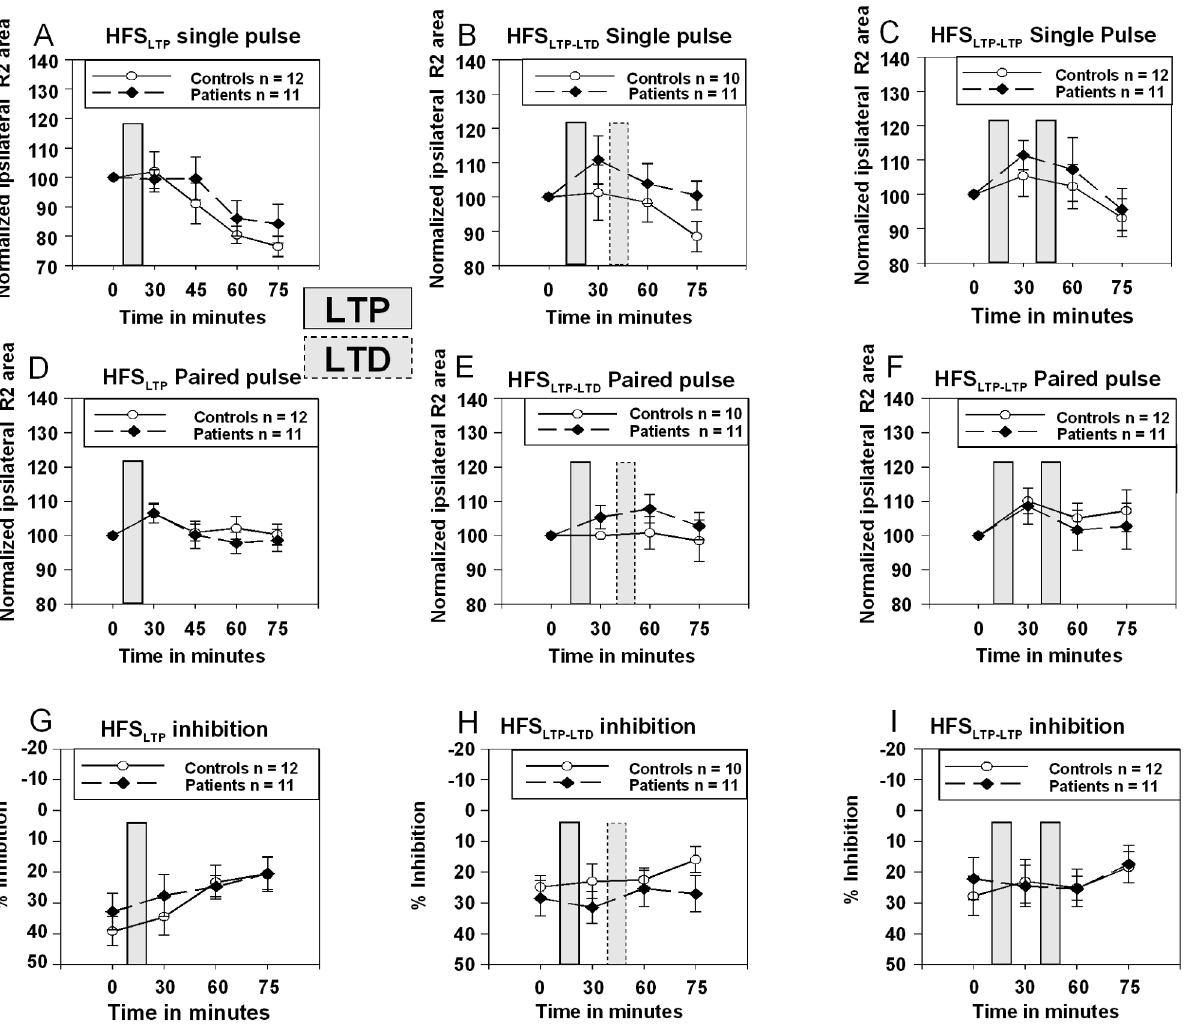
Figure 4. Presentation of normalized data for HFS LTP , HFS LTP-LTD , HFS LTP-LTP protocols. Panels A–C show the normalized area under the curve of the ipsilateral R2 response after single pulse stimulation. HFS LTP , HFS LTP-LTD , HFS LTP-LTP were applied in patients and controls. In panels D, E, F the ipsilateral R2 area under the curve after paired-pulse stimulation are depicted. In panels G,H,I the % inhibition is shown. Here, inhibition was determined as percent change from the R2 response after paired-pulse stimulation relative to single pulse stimulation. Single pulse stimulation revealed a nonspecific decrease of the R2 response in all protocols and in both groups. After paired-pulse inhibition no changes were found, because the decrease of the R2 response was accompanied by a decrease of % inhibition (higher values indicate stronger inhibition). R2 area under the curve is given in m V/sec. Mean and standard error are shown. Open circles indicate controls, black diamonds patients.